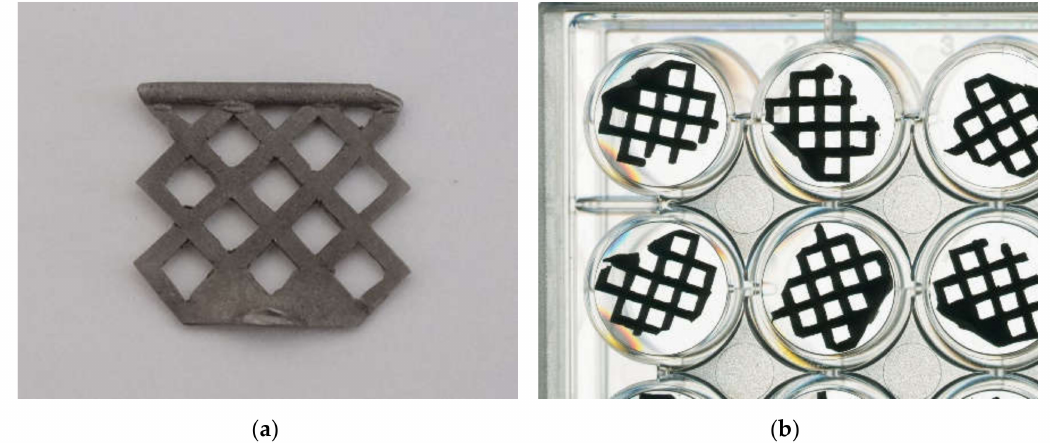
Figure 12. The casted and cleaned grids ( a ) with or without a calcium titanate reaction layer were used in 24-well plates ( b